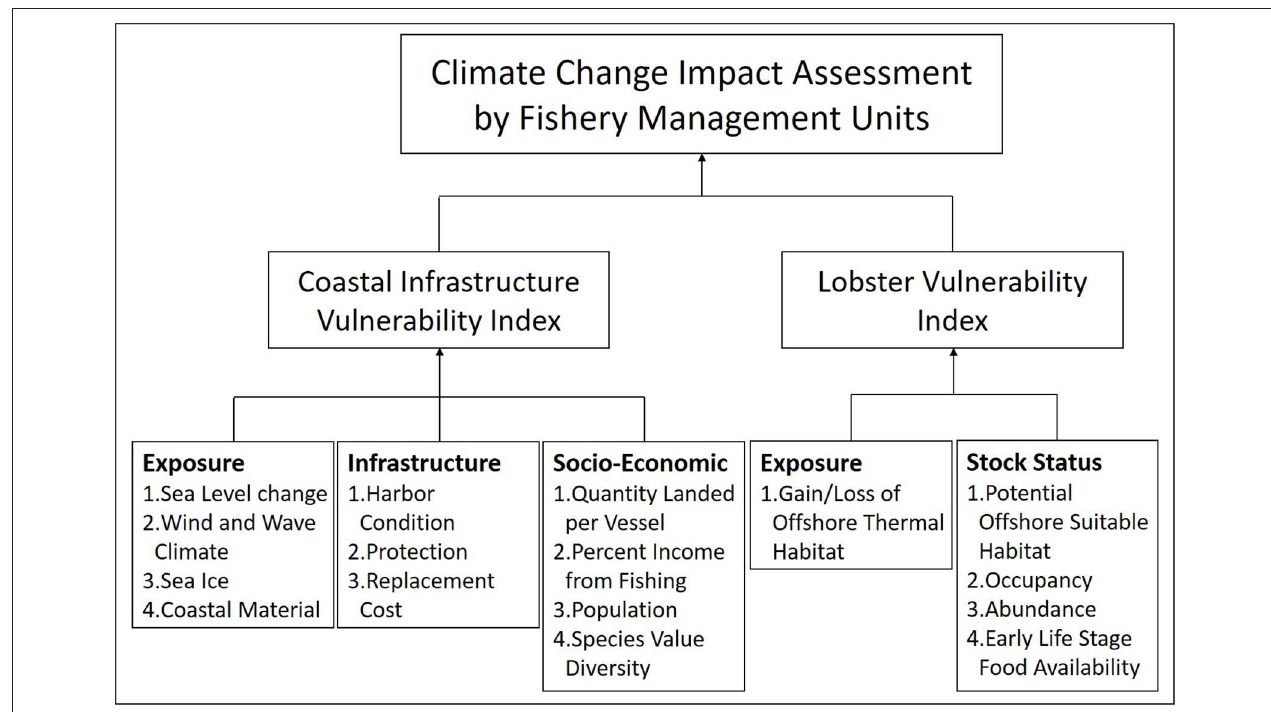
FIGURE 2 | Flowchart of vulnerability indices, sub-indices, and components that contribute to an overall climate change impact assessment by fishery management